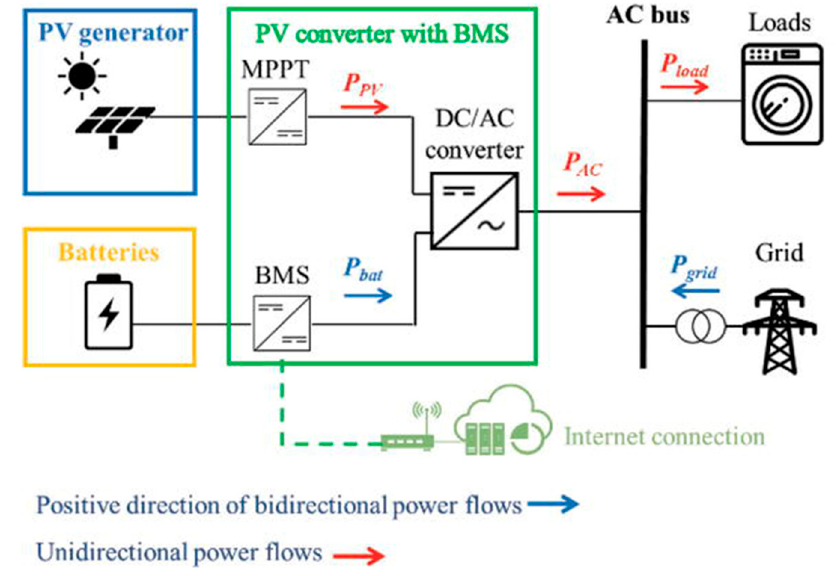
Figure 4. Solar PV-Battery Energy Storage System.